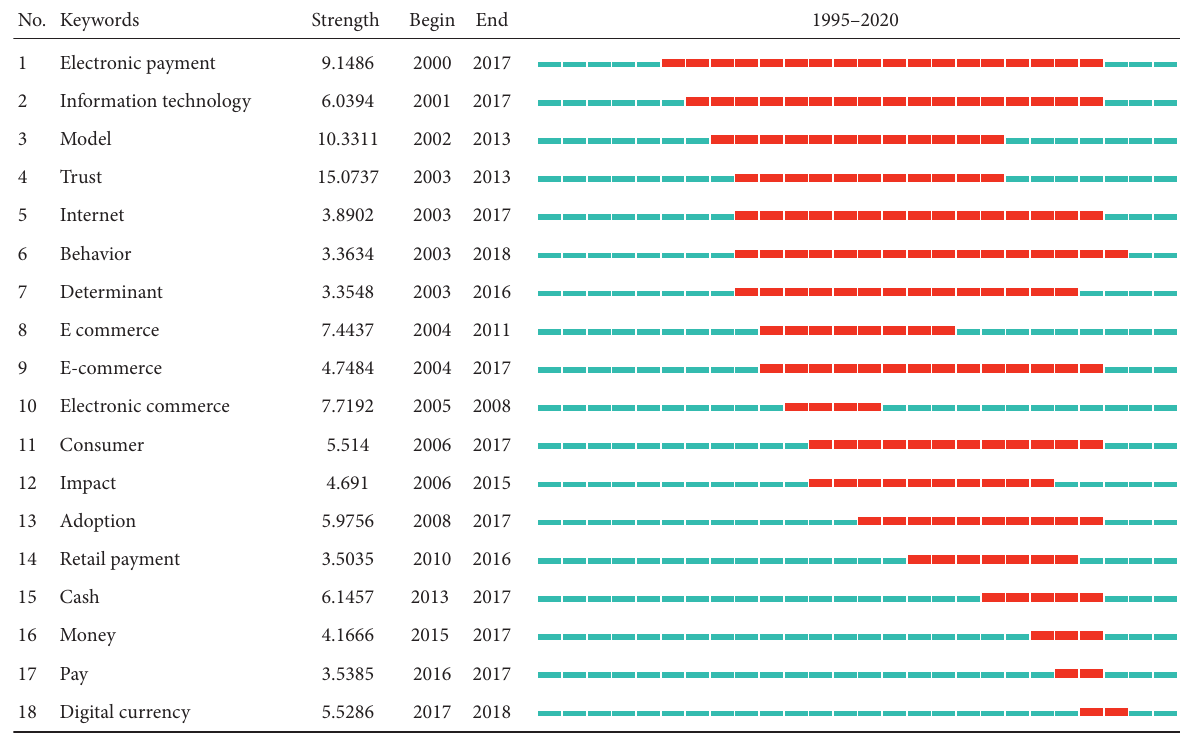
Figure 8: Keywords with the strongest citation bursts, ranked by the beginning year of